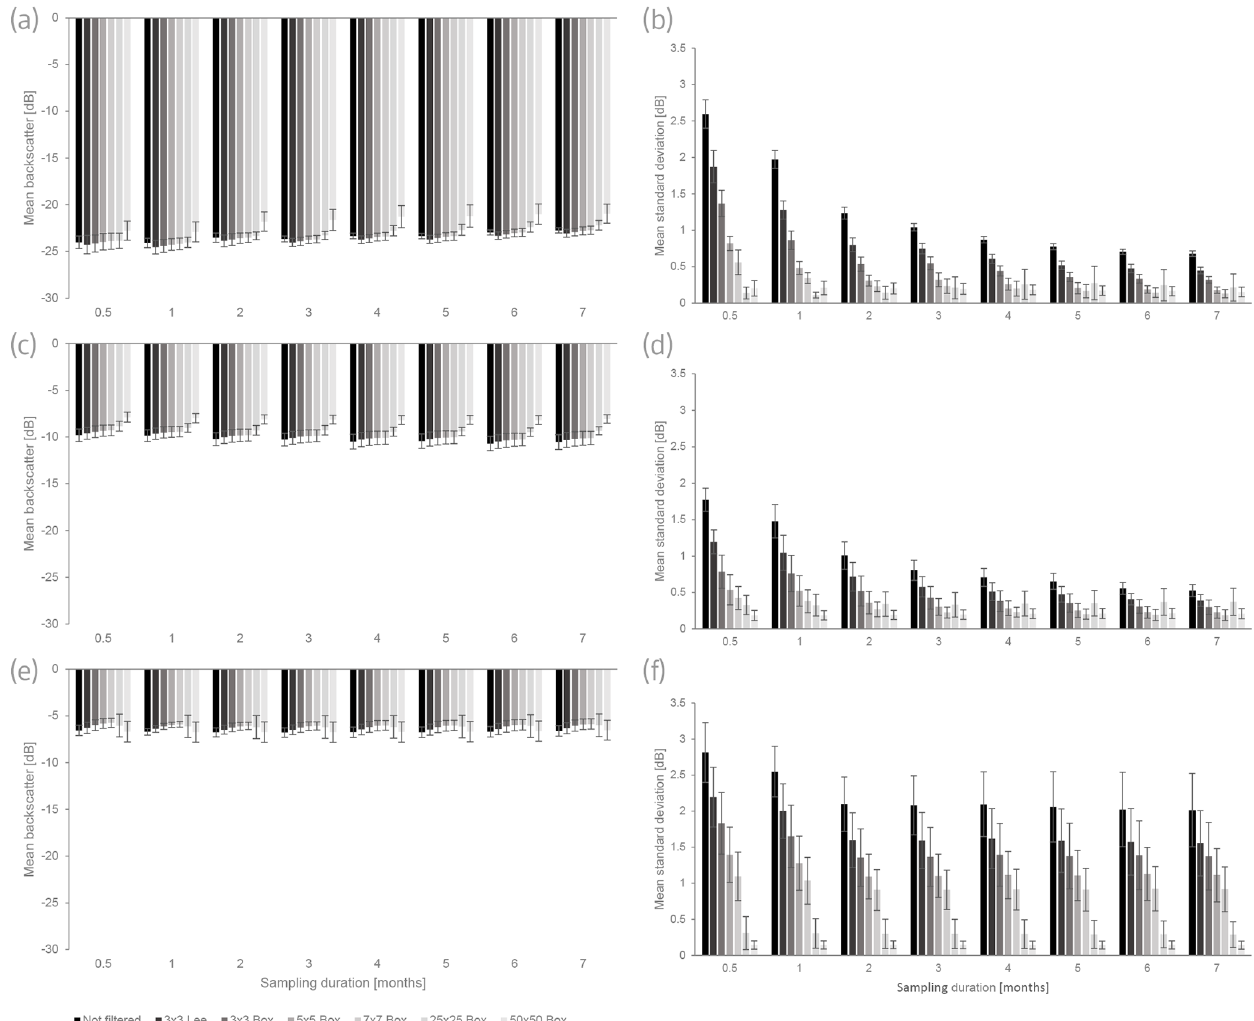
Figure A3. Average backscatter (a, c, e) and average standard deviation (b, d, f) of the pixels within 10 patches of water (a, b) , fields (c, d) and trees (e, f) for different sampling durations and filter sizes. Bars indicate the 95% confidence interval. Lee – Lee filter. Box – boxcar